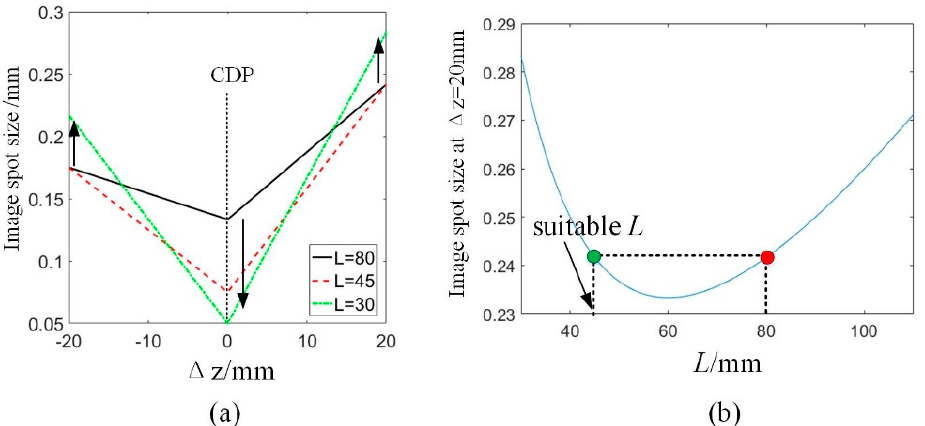
Figure 3. ( a ) The relationship between image spot size S and defocused depth ∆ z at different capturing depth L , with ∆ x 1 = 5 µ m. ( b ) The relationship between L and image spot size at ∆ z = 20 mm, with ∆ x 1 = 5 μ m.